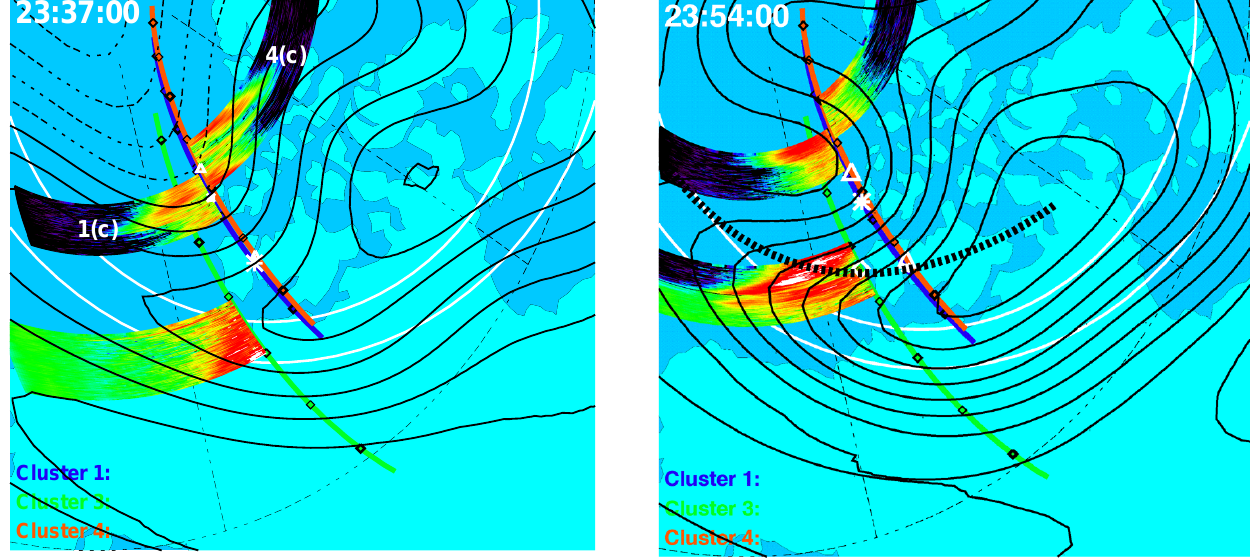
Fig. 7. Composite plot of Cluster magnetic footpoints and iono- spheric convection streamlines for 25 July 2001, at 23:54UT. Over- layed on the magnetic footpoints are 14-min wide sections of the Cluster/CIS flux measurements presented in Plate 1, and centered on the actual position of the Cluster satellites at 23:54UT. SC1 and SC4 observe low energy ion outflow typical for the high-latitude re- gion poleward of the cusp. SC3 has finally reached the cusp and encounters the typical cusp ion energy dispersion with higher en- ergy ions arriving at subsequently higher